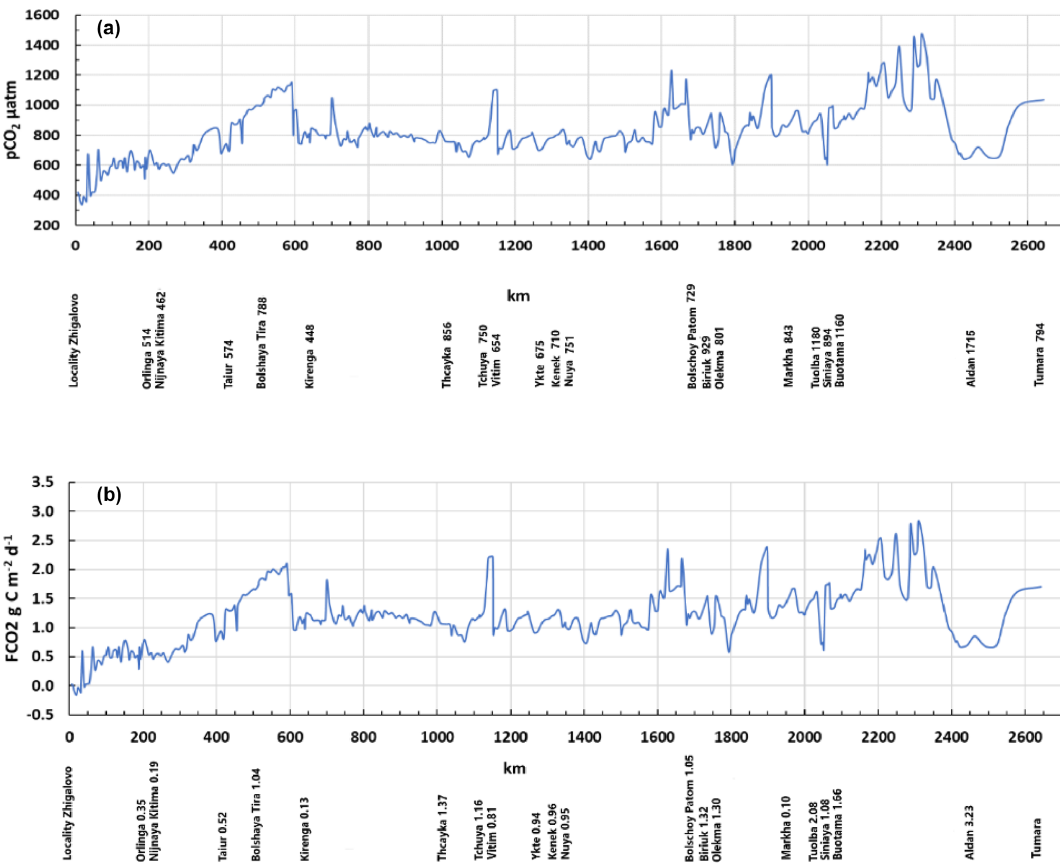
Figure 2. A 20km averaged p CO 2 profile (a) and calculated CO 2 fluxes (b) of the Lena River main stem of over 2600km distance, from Zhigalovo to the Tumara River. The average p CO 2 (µatm) and fluxes (gCm − 2 d − 1 ) of the main sampled tributaries are provided as numbers below the x axis. Note that peaks of CO 2 concentration at the main stem are not linked to conflux with